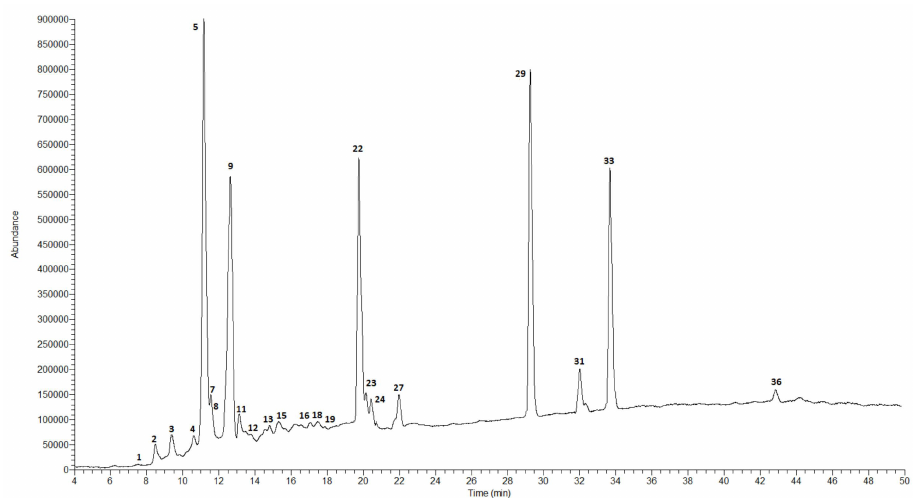
Figure 1. LC-MS chromatogram in SCAN mode for the methanol–acetone–water extract from the fruits of C. nebrodensis .